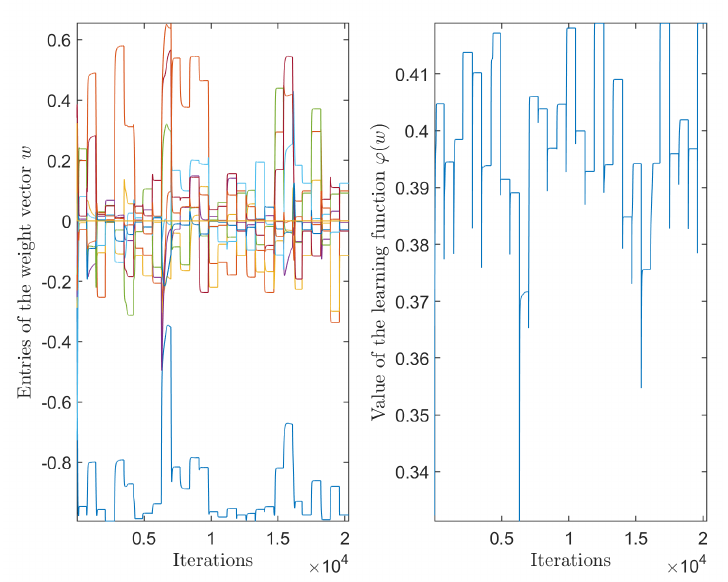
Figure 18. Learning curves resulting from a sequential presentation of 29 images belonging to a plate- tag dataset. In both panels, one may count exactly 29 plateaus, which correspond to 29 seemingly independent partial learning curves.